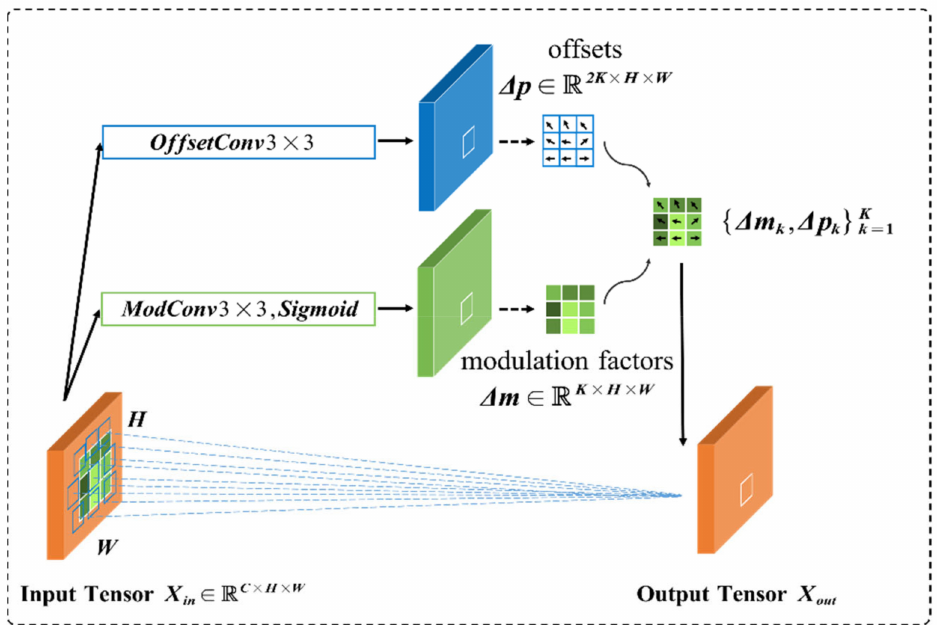
Figure 3. Implementation of deformable